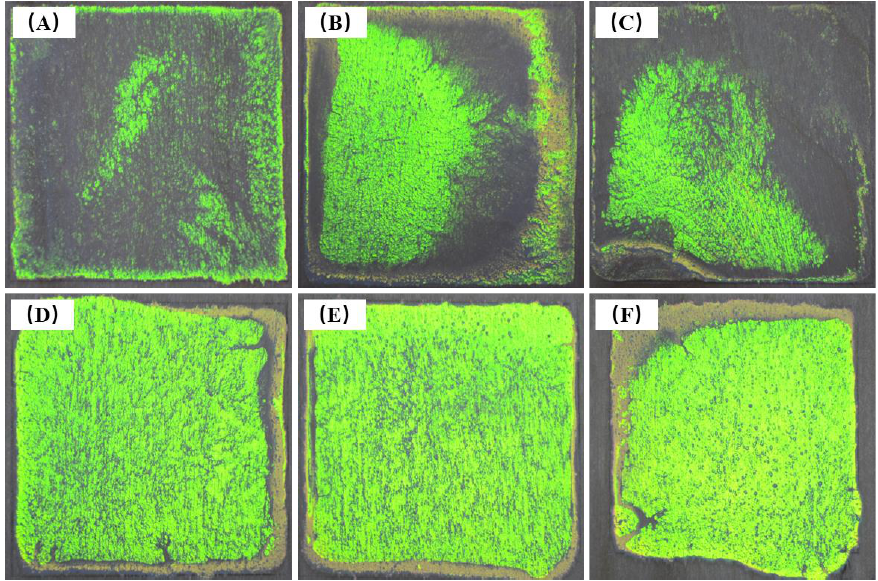
Figure 15. Photos of photonic crystals formed by different amounts of P(St-AA) emulsions on 35 mm × 35 mm wood surface: ( A ) 100 μL; ( B ) 200 μL; ( C ) 300 μL; ( D ) 400 μL; ( E ) 500 μL; ( F ) 600 μL . Visible light spectrophotometry was used to characterize the reflectance spectra of P(St-AA) photonic crystals on the wood surface (Figure 16). The photonic crystals had two reflection peaks at 425 nm and 524 nm. The peak at 524 nm was consistent with the particle size of colloidal microspheres (222.4 nm) and yellow-green structural color, which conformed to Bragg diffraction. The peak near 425 nm was the reflection peak of the P(St- AA) colloidal microspheres [41]. When the emulsion amounts were 100 and 200 μL, the spectra were different from that of a higher coating amount. When the coating amount was 100 μL, the curve was similar to uncoated wood, and only two extremely weak peaks were observed at 429 nm and 548 nm. There were fewer colloidal microspheres and the effective photonic crystal region was small. When the coating amount increased to 200 μL, the two peaks became more obvious, and both underwent a blue shift. The coating had photonic crystal structure but not enough to cover the entire surface. The reflectance spectra were similar upon increasing the coating amount. When the coating amount was 500 μL, the half -peak width of the coating was the smallest, which indicated that the coating had the best effect.